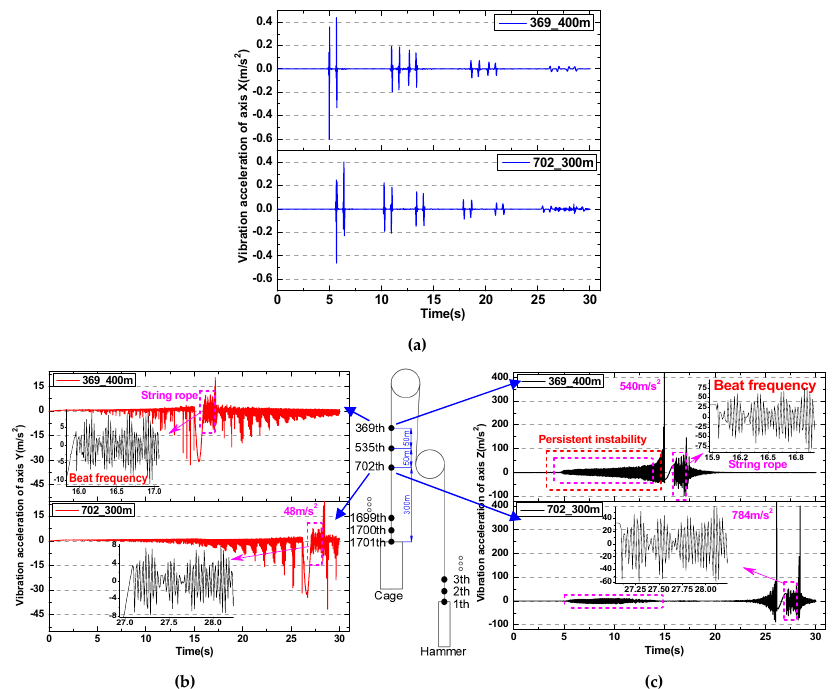
Figure 12. Rope vibration in three directions in the process of wrapping the friction pulley. ( a ) X-axis—short side direction of the cage; ( b ) Y axis—vertical direction of the cage; ( c ) Z-axis—long side direction of the cage.